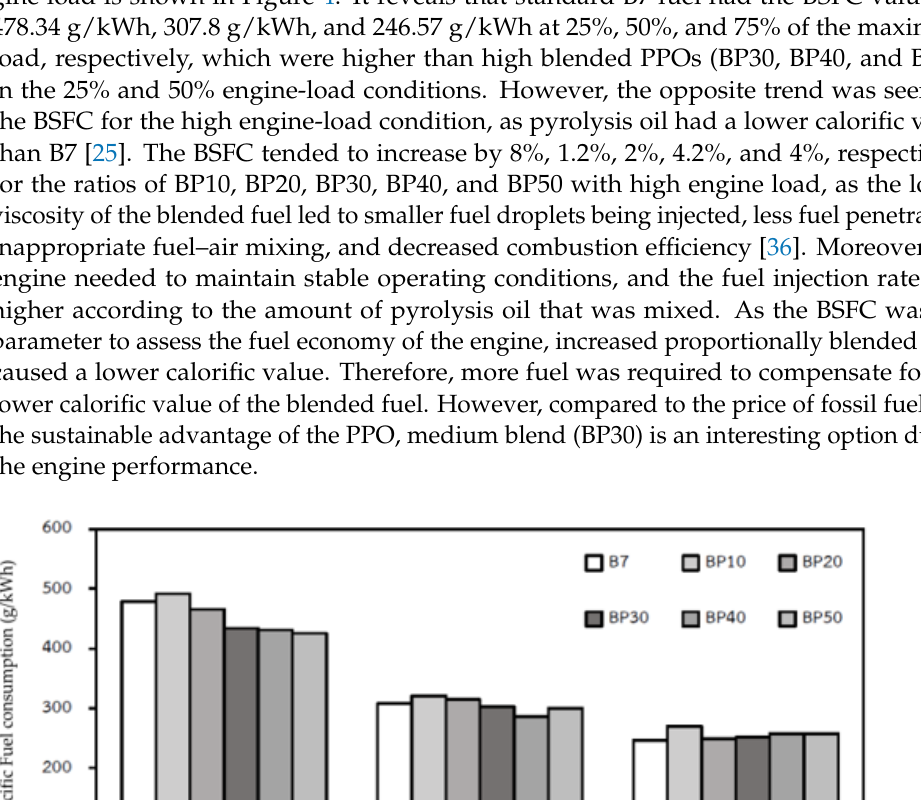
Figure 3. Effects of fuel blends on in-cylinder peak pressure under various engine loads.